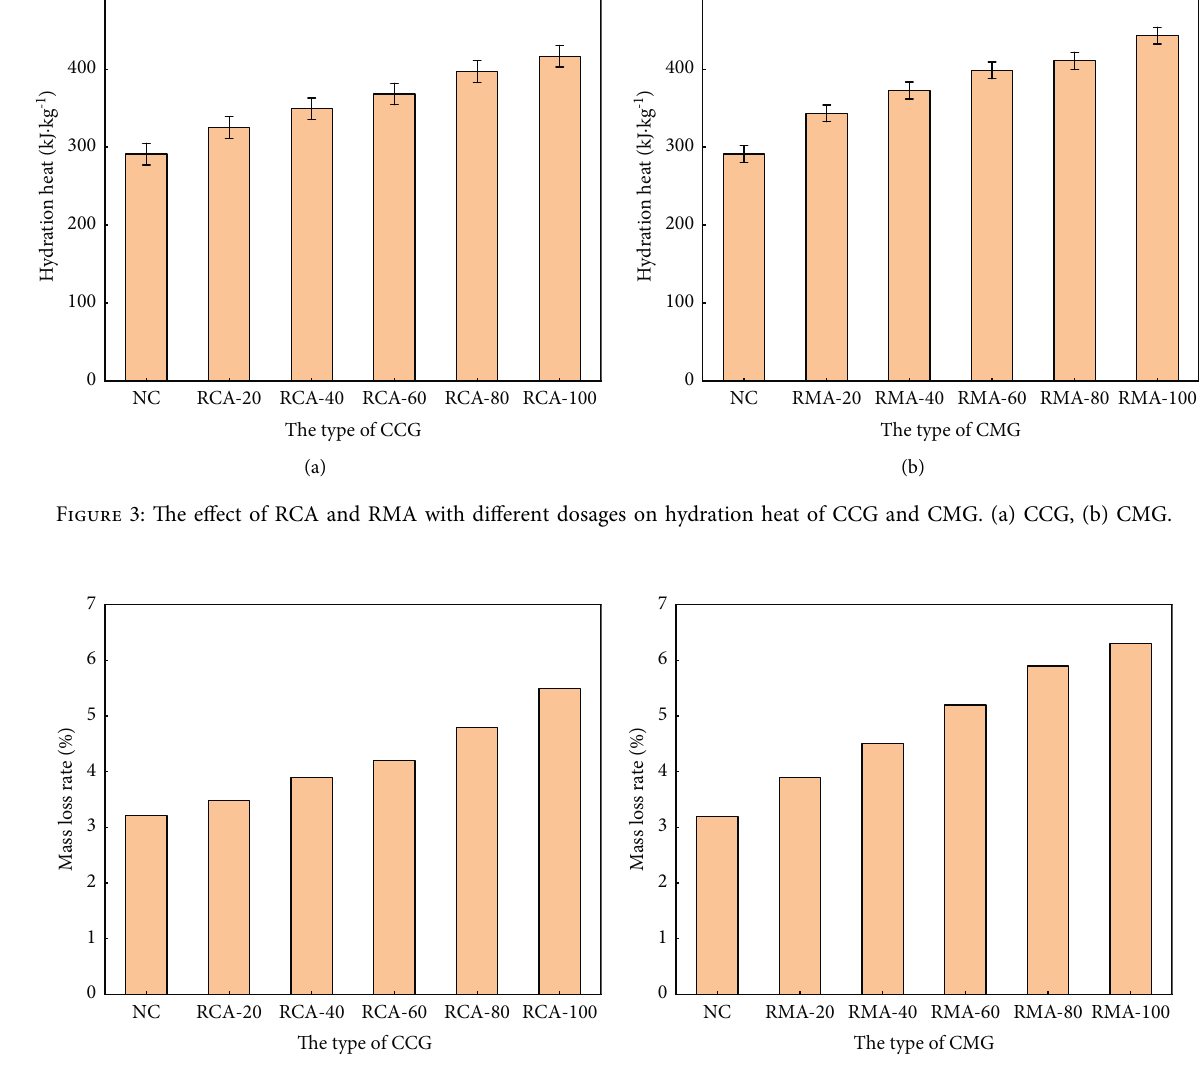
CCGNC The type of Figure 4: The effect of RCA and RMA with different dosages on mass loss rate of CCG and CMG. (a) CCG, (b)